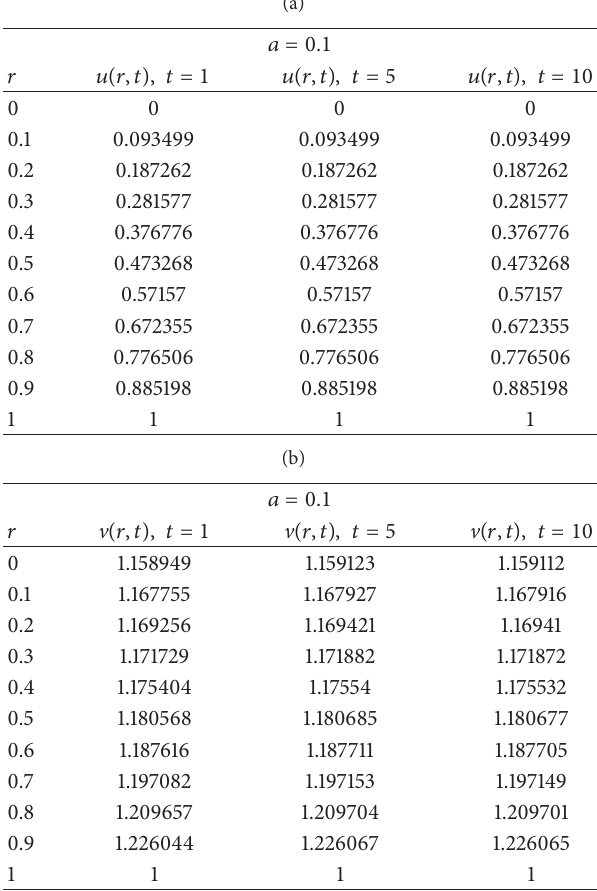
Table 1: The influence of time values on fluid velocity